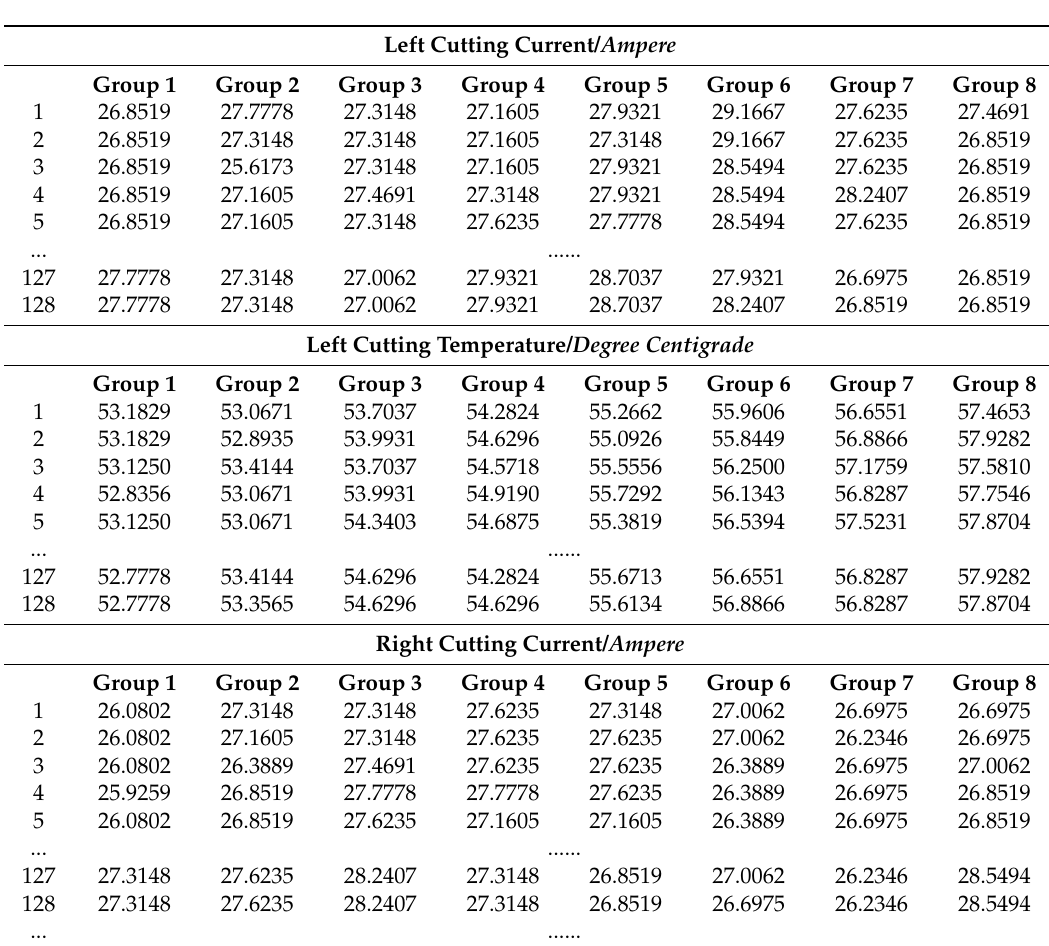
Figure 6. Feature curve of the left cutting current. Table 1. Field sensor